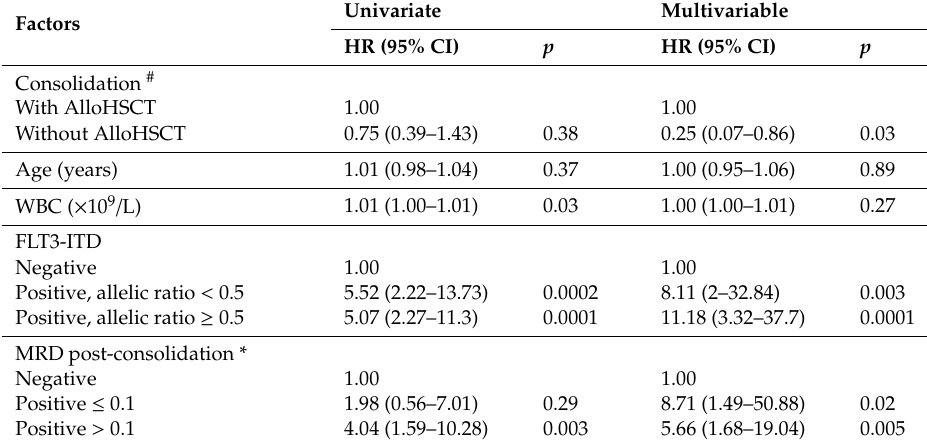
Table 3. Univariate and multivariable analysis for disease-free survival among 86 patients in CR after